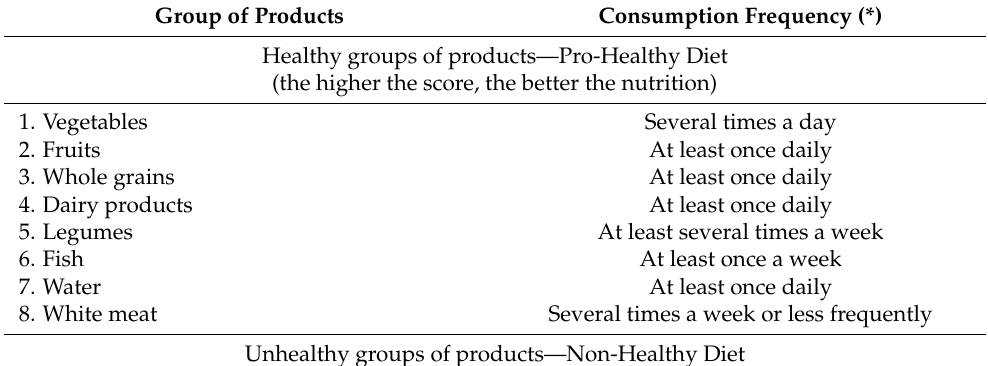
Table 1. Components of the total scores for pro-healthy and non-healthy